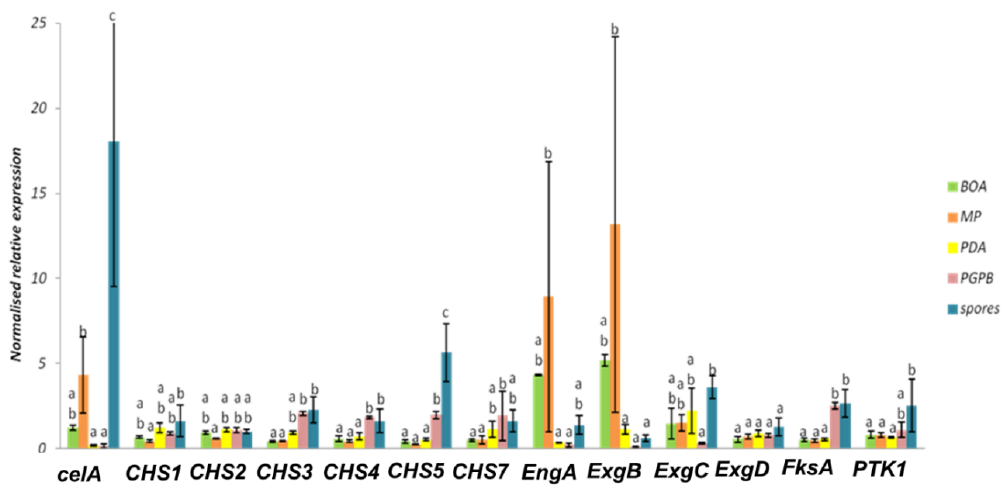
Figure 6. Normalized relative expression of cell wall genes of D. teres cultivated on different media. Different letters indicate statistically different values ( p -value < 0.05) among the groups of the one-way ANOVA with Tukey’s post-hoc test. Error bars represent the standard deviation of four independent biological replicates.